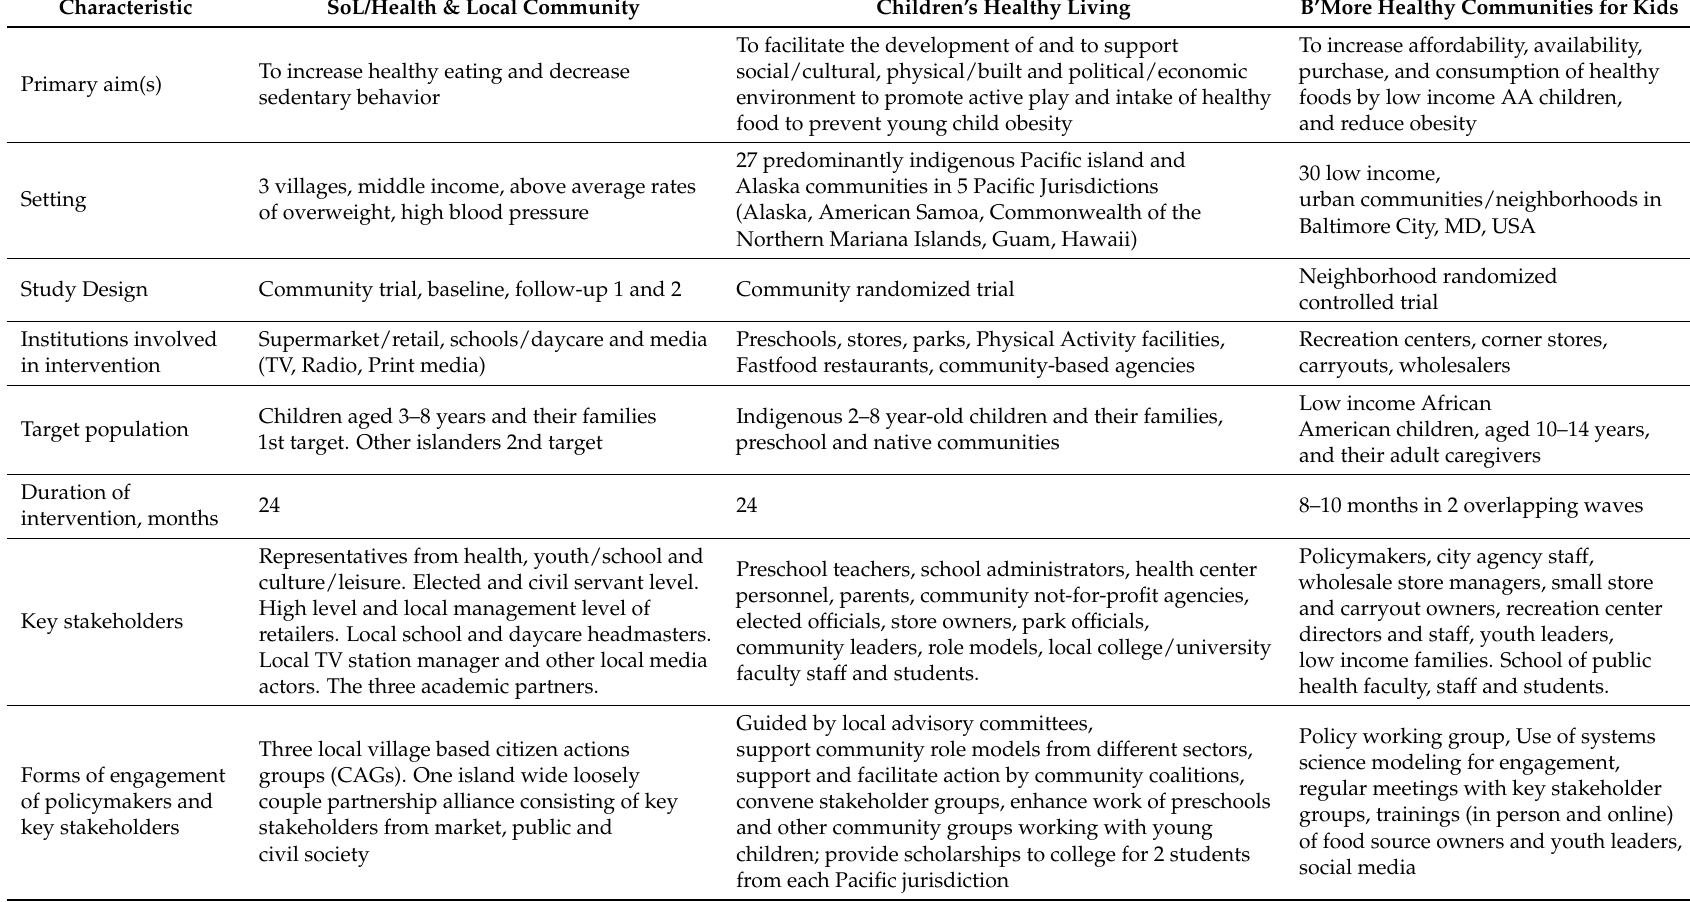
Table 2. Characteristics of the three Multilevel-Multicomponent (ML-MC) community-based intervention